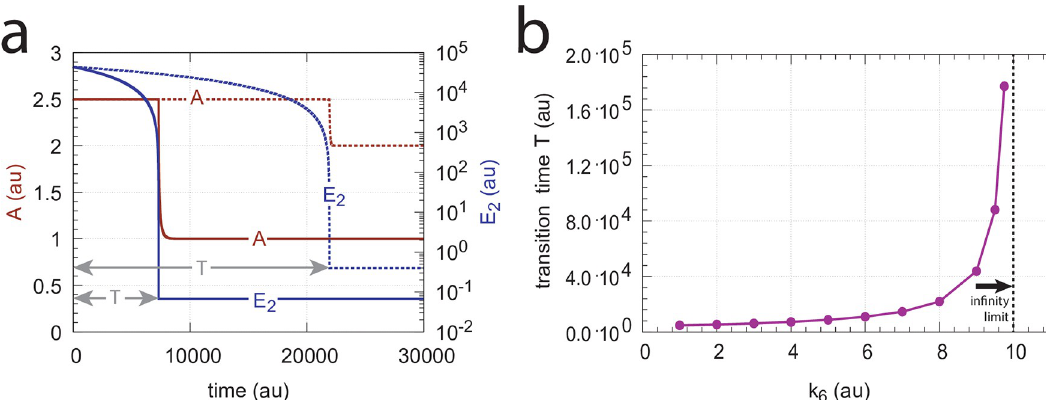
Fig 14. Critical slowing down in the transition from single-E to dual-E control in the negative feedback loop of Fig 11b. The set- point of A during single-E control is 2.5, but 1.0 during dual-E control. Panel a: Time profiles of A and E 2 for k 6 =4.0 (solid lines) and k 6 =8.0 (dotted lines). T, the transition time, is the time difference from t = 0 until E 2 has reached steady state. Panel b: T as a function of k 6 . When k 6 ! 10.0 the steady state of the dual-E control mode vanishes and T !1 . Rate constants (for each data point): k 1 =0.0, k 2 =10.0, k 3 =1 × 10 5 , k 4 =1.0, k 5 =4.0, k 6 takes the values 1.0, 2.0, ... , 9.0, 9.5 and 9.75, k 7 =1 × 10 7 , k 8 =0.1, k 13 = k 15 =1 × 10 8 , k 14 = k 16 =1 × 10 3 . Initial concentrations: A 0 =2.5, E 1,0 =3.635 × 10 2 , E 2,0 =4.38 × 10 4 , Ez 0 =2.28 × 10 − 13 , (E 1 � Ez � E 2 ) 0 =1.0 × 10 − 6 , (Ez � E 2 ) 0 =2.75 × 10 − 11